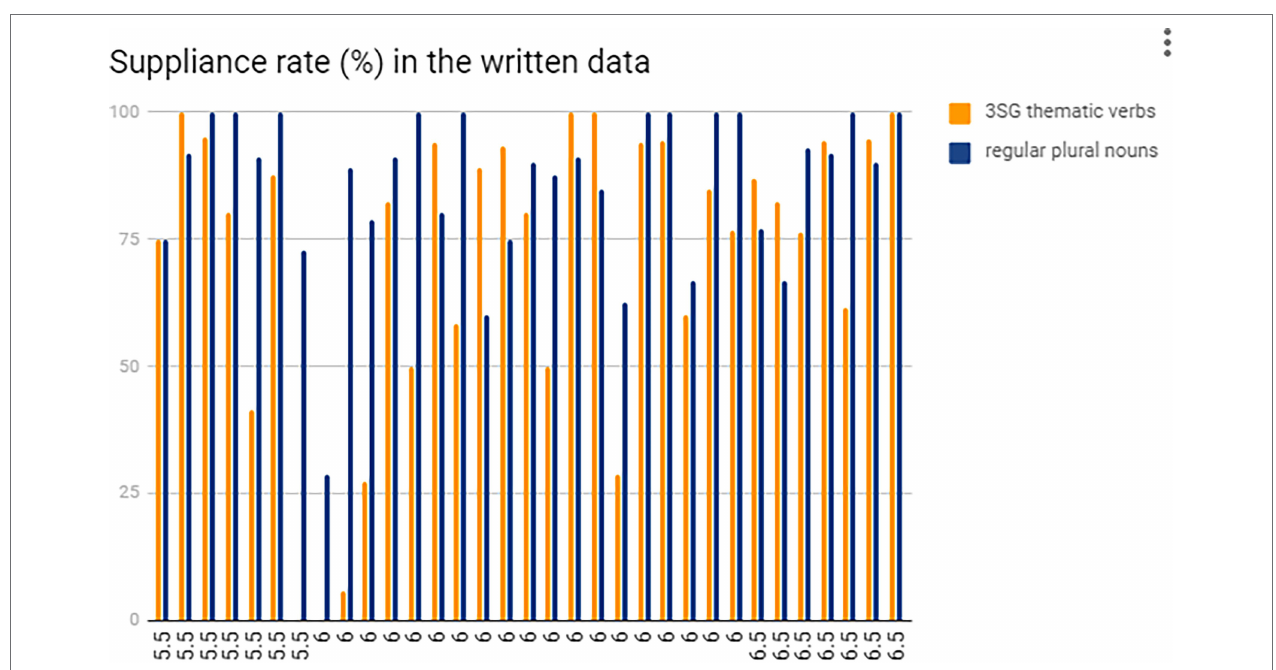
FIGURE 5 | The comparison of suppliance rates between 3SG ‘ -s ’ and plural ‘ -s ’: individual results in the written